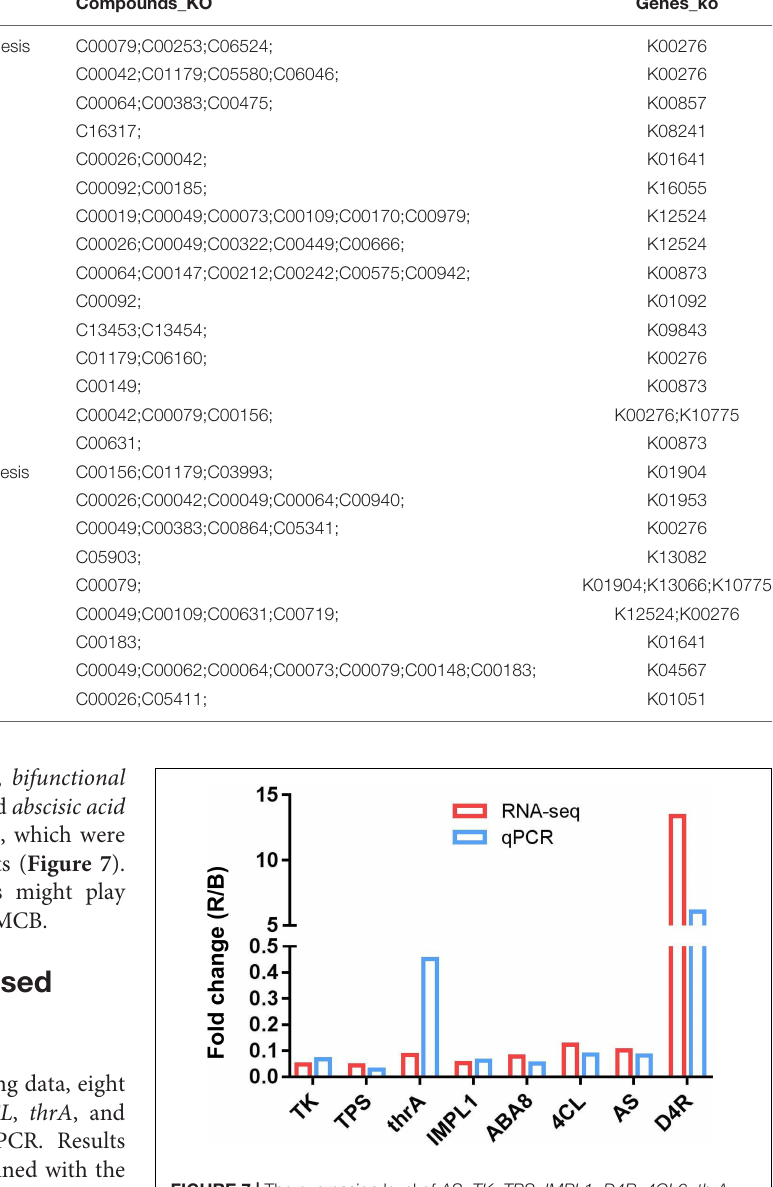
FIGURE 7 | The expression level of AS , TK , TPS , IMPL1 , D4R , 4CL6, thrA , and ABA8 between the red- and blue-light